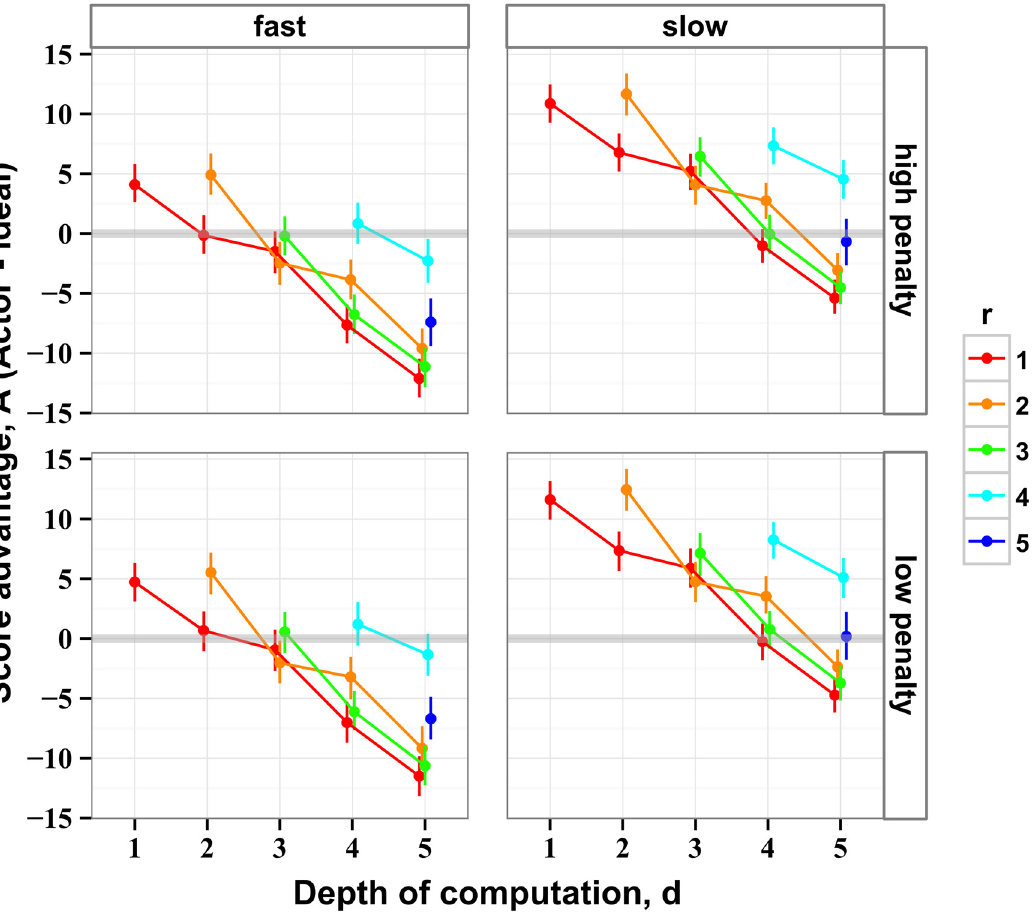
Fig 6. Score advantage of humans over ideal actors. Score advantage is the difference of the scores collected by human and ideal actors, the latter characterized by two fixed parameters: depth of computation d and recalculation period r , (Eq 1). The difference was accumulated over the last three stimulus rows where the differences between the human and ideal scores were the largest. The zero-crossings (where human behavior was most similar to that of ideal actors) were used to estimate the strategy used by humans. The data are shown for all experimental conditions: two stimulus speeds (fast and slow) and two magnitudes of penalty (high and low). The points are the means and the error bars are the 95% confidence